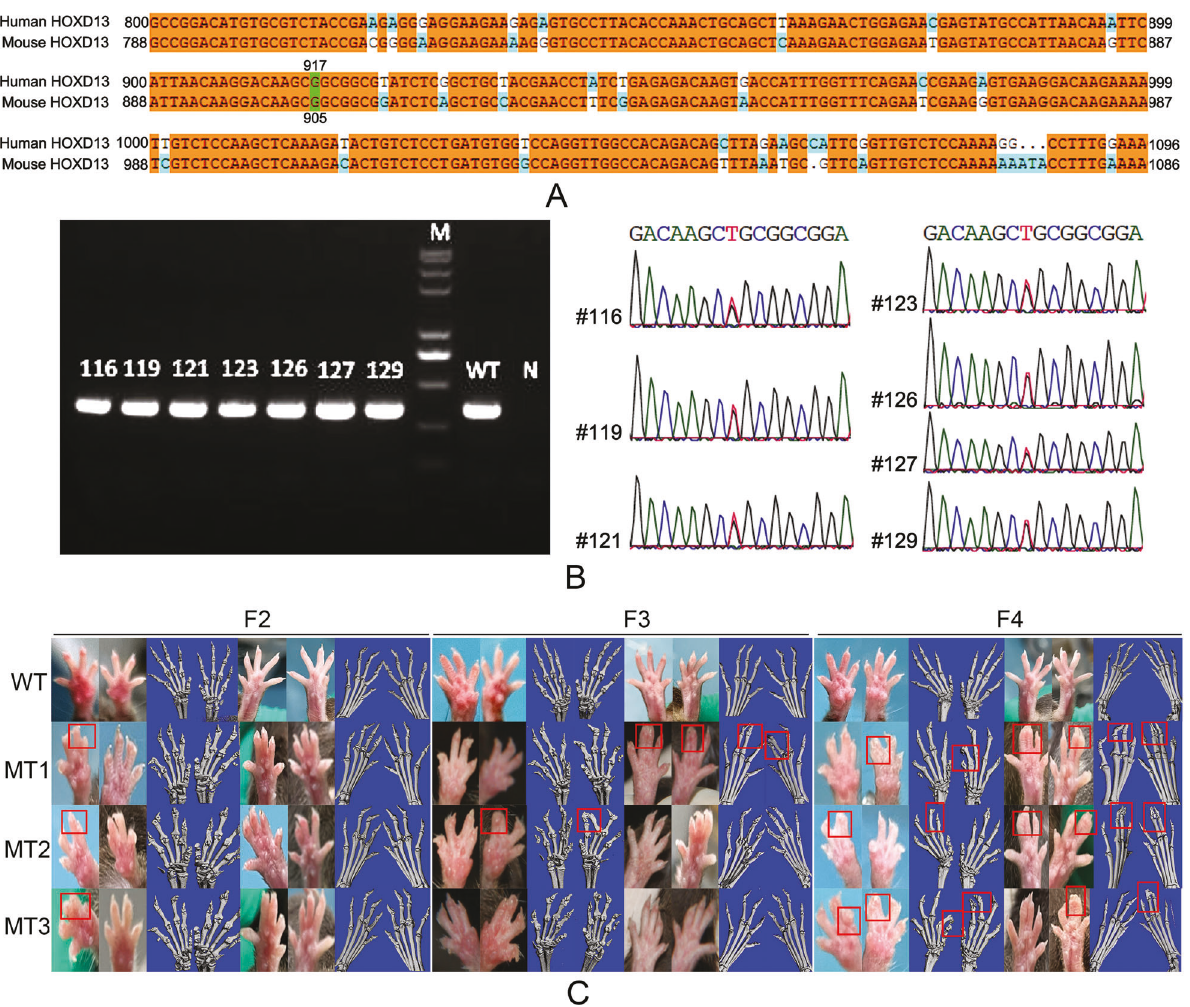
micro-CT. All experiments were repeated three